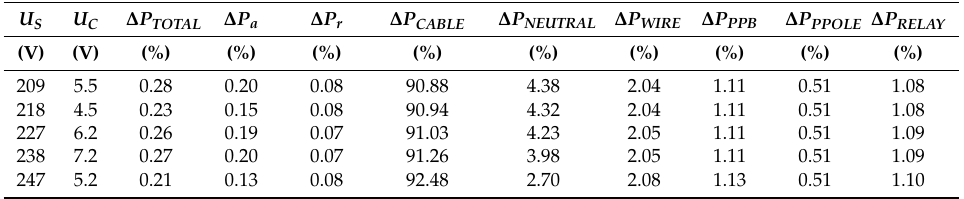
Table 9. Computed power